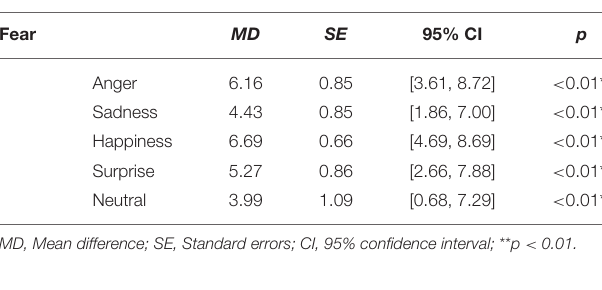
TABLE 4 | Mean differences of reaction times for all discrete emotions.